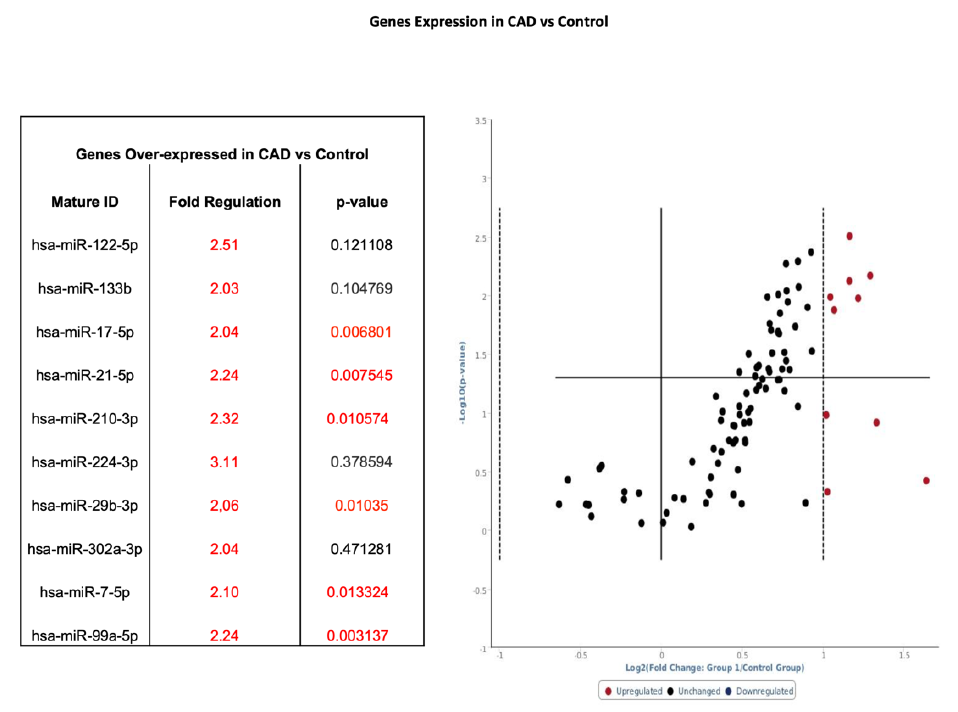
Figure 3. Volcano plot with corresponding table showing the comparison of miRNA assessed by microarray (84 genes) isolated from patients with CAD ( n = 16) versus healthy controls ( n = 16). Designation of significance (RED) was given to samples with fold change >2. Samples with p values < 0.05 and fold change > 2 are found in the upper right quadrant. CAD—Coronary Artery Disease.